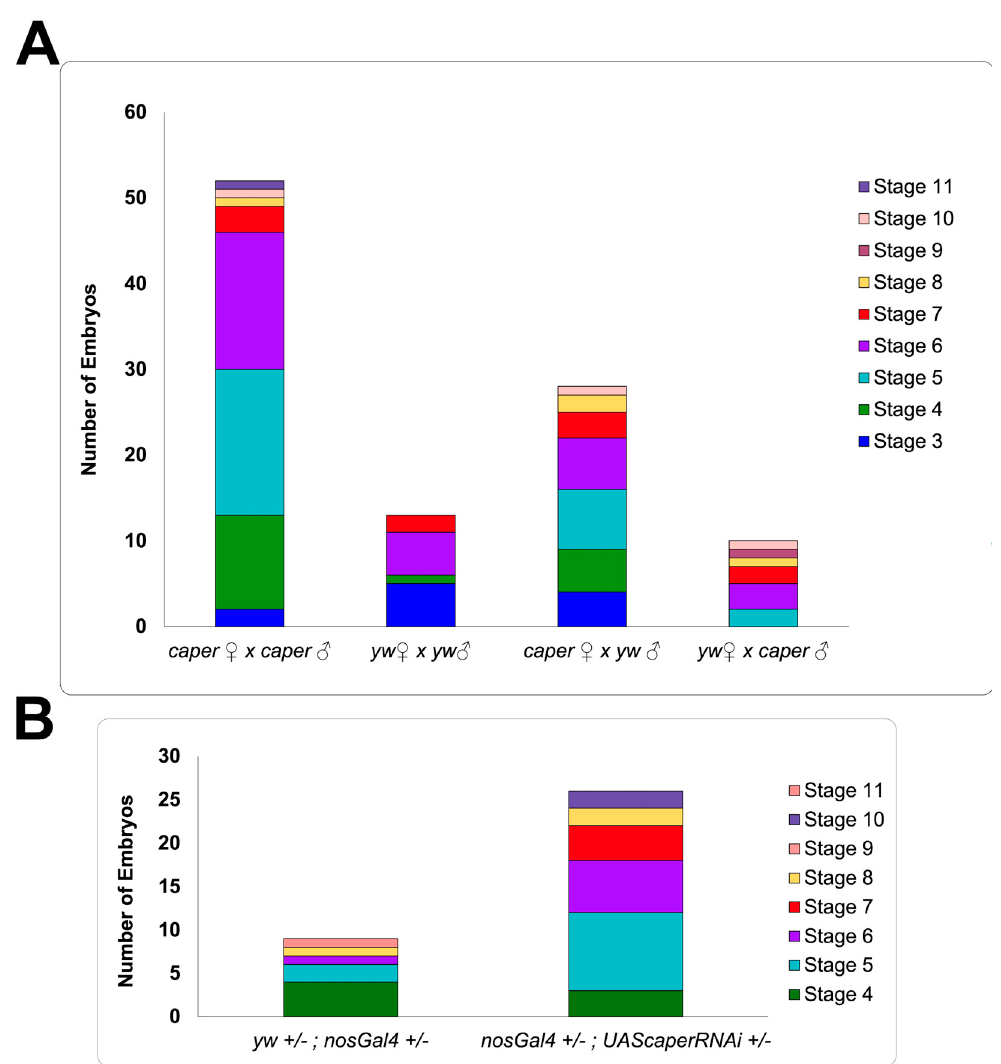
Figure 3. Stages during which embryos arrest development due to caper dysfunction. ( A ) The number of embryos that did not complete development and the stage at which they arrested is shown. Number of embryos is plotted on the y -axis; parental genotypes are indicated on the x -axis. caper − / − embryos die significantly more than yw embryos ( caper − / − n = 696, 7.47% dead; yw n = 759, 1.71% dead; Tukey’s test: z -ratio = − 4.9, p = 6.58 × 10 − 6 ) and caper +/ − embryos derived from caper mutant females outcrossed to yw males (n = 793, 3.53% dead; Tukey’s test: z -ratio = − 3.3, p = 0.0055) or yw females outcrossed to caper mutant males (Tukey’s test: z -ratio = − 5.4, p = 3.45 × 10 − 7 ). More caper +/ − embryos derived from caper mutant females outcrossed to yw males are embryonically arrested than embryos derived from yw females outcrossed to caper mutant males (n = 834, 1.20% dead; Tukey’s test: z -ratio = − 3.0, p = 0.016). ( B ) Knockdown of caper specifically within the female germline results in a significant increase in the arrest of embryonic development compared to controls (GLM: χ 2 = 9.7, p = 0.00186).